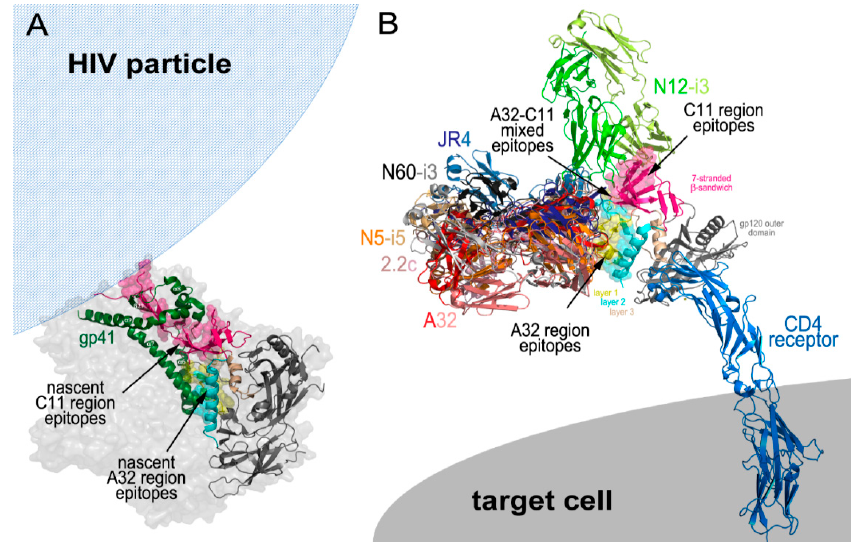
Figure 2. HIV-1 Epitopes. ( A ) Structure of a native, un-triggered virion-associated HIV-1 trimer showing the location of nascent C11 region and A32 region epitopes enclosed in the center of the non-CD4 bound trimer. ( B ) Structure of the HIV-1 trimer in the CD4 receptor bound confirmation. Binding exposes the C11, A32, and A32–C11 mixed epitope regions. The binding sites of all antibodies